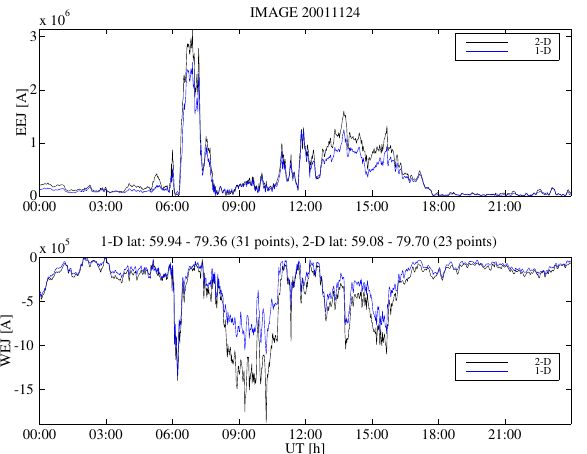
Fig. 6. Hall currents and (cid:2)eld-aligned currents (10 sec running mean) during the storm event on 5/6 Nov. 2001